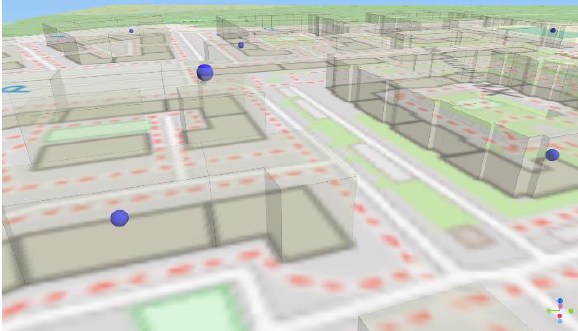
Figure 5 . Approximate location of hotbeds in buildings in Yuntolovo.